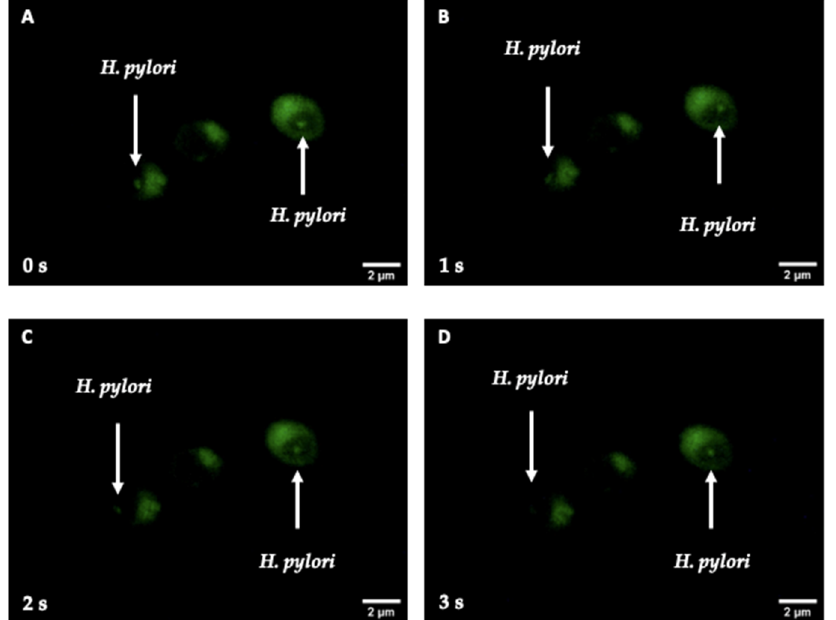
Figure 10. Fluorescence microscopy of C. glabrata LEO-37 strain cells co-cultured with H. pylori G-27 strain cells under microaerobic condition for 48 h, and then cultured on Sabouraud agar plus chloramphenicol for 24 h to eradicate bacteria extracellularly located. The viability of bacteria harboring within Candida cells was demonstrated by SYTO 9 green fluorescence within yeast cells (white arrows). Images ( A – D ) were obtained from the same microscopic field at 1 s intervals showing the change of position of bacteria located in the vacuole of Candida cells.